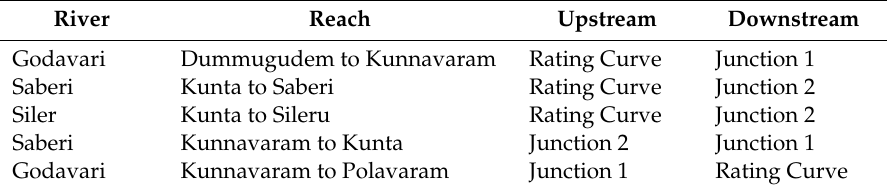
Table 2. Boundary conditions applied at the end of each reach for the 1D steady flow.